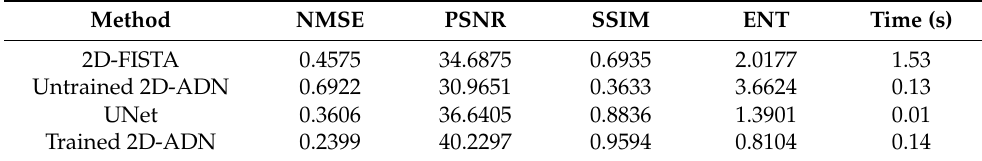
Table 3. Quantitative performance evaluation for the incomplete range simulation data.